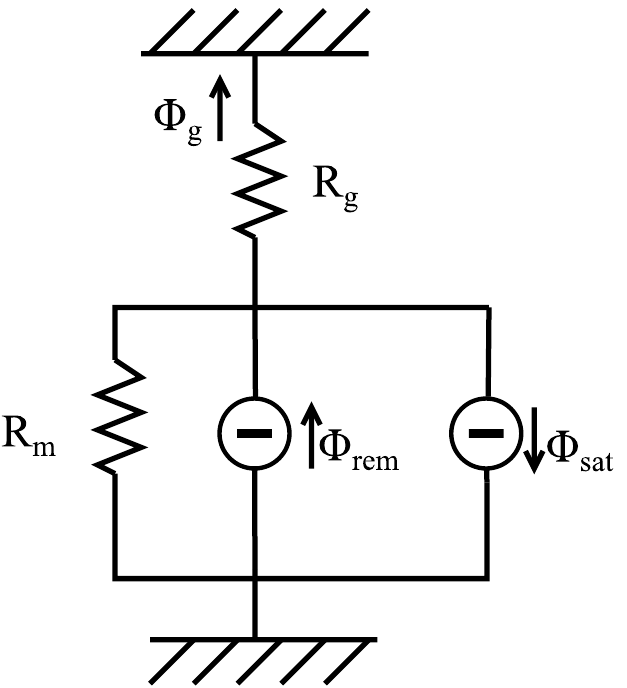
Figure 9. Magnetic equivalent circuit of the PM